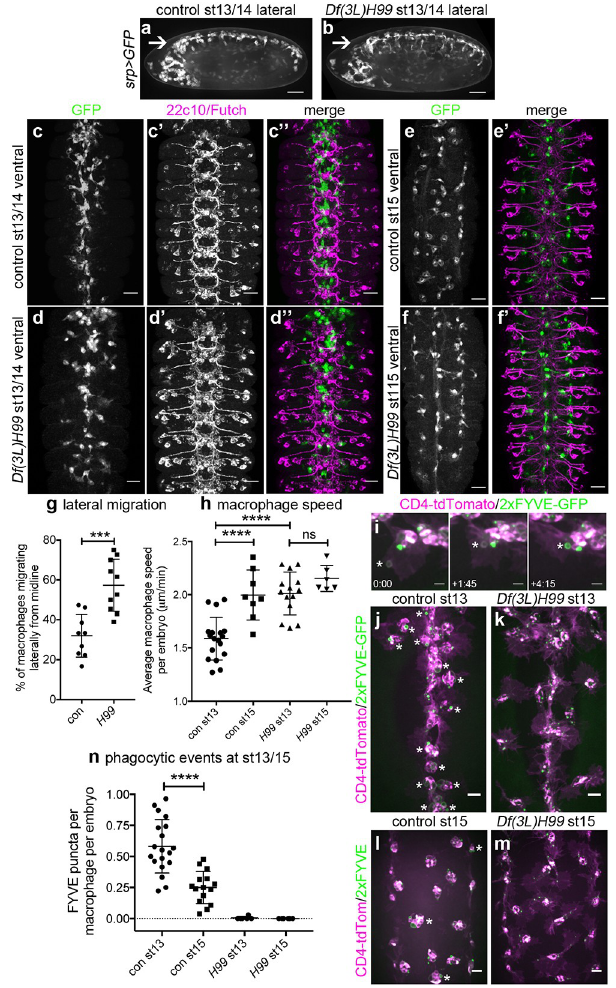
Fig 1. Apoptotic cell death contributes to developmental dispersal of Drosophila embryonic macrophages. (a–b) Lateral projections (anterior is left) of control ( w;srp-GAL4 , UAS-GFP ) and apoptosis-null Df(3L)H99 mutant embryos ( w;srp-GAL4 , UAS-GFP;Df(3L)H99 ) showing macrophage distribution at stage 13/14 of development, including along ventral midline (arrow). (c–d) Ventral projections (anterior is up) showing macrophages (anti-GFP staining, green in merge) and structure of the CNS (22c10/anti-Futch staining, purple in merge) at stage 13 of development in controls ( w;;crq-GAL4 , UAS-GFP ) and in the absence of apoptosis ( w;;Df(3L)H99 , crq-GAL4 , UAS-GFP ).Macrophage projections constructed from z-slices corresponding to superficial macrophages on the ventral side of the VNC only, whereas Futch projection covers the entire volume of the VNC. (e–f) Ventral projections (anterior is up) showing macrophage distribution (GFP) alone (e–f), or merged with Futch staining (e’–f’) to show CNS structure in control and Df(3L)H99 mutant embryos at stage 15 (genotypes as per c–d). (g) Scatterplot showing percentage of macrophages on the midline that move laterally at stage 13 of development in control and apoptosis-null embryos ( n = 9 and 10, respectively; P = 0.0006, Mann–Whitney test); lateral migration concludes around the end of stage 14. (h) Scatterplot showing speed per macrophage, per embryo ( μ m per min) in control and apoptosis-null embryos at stage 13 ( P < 0.0001) and stage 15 ( n = 18, 8, 14, 6 [left–right]; P = 0.47, one-way ANOVA with Tukey’s multiple comparison test). Genotypes in (g–h) are as per (c–f). (i) Stills from movie of macrophages phagocytosing at stage 13 on the ventral midline in a control embryo ( w;srp-GAL4 , UAS-2xFYVE-GFP;crq-GAL4 , UAS-CD4-tdTomato ).GFP and tdTomato are shown in green and purple, respectively, while asterisk shows nascent phagosome at indicated times (mins:secs) as it becomes positive for the PI3P sensor 2xFYVE-GFP post engulfment; CD4-tdTomato labels membranes. (j–m) Ventral projections of control ( w;srp-GAL4 , UAS-2xFYVE-GFP;crq-GAL4 , UAS-tdTomato )and apoptosis-null embryos ( w;srp-GAL4 , UAS- 2xFYVE-GFP;crq-GAL4 , UAS-tdTomato;Df(3L)H99 ) at stage 13 (j–k) and stage 15 (l–m), showing recent phagocytic events via 2xFYVE-GFP sensor for PI3P. Asterisks show examples of 2xFYVE-GFP positive cells (j, l). (n) Scatterplot showing number of phagocytic events (via 2xFYVE-GFP positive vacuoles) per macrophage, per embryo at stages 13 and 15 ( n = 19 and 15, respectively; P < 0.0001, Mann–Whitney test). Lines and error bars show mean and standard deviation (g–h, n); ��� and ���� denote P < 0.001 and P < 0.0001; scale bars represent 50 μ m (a–b), 10 μ m (c–f), 5 μ m